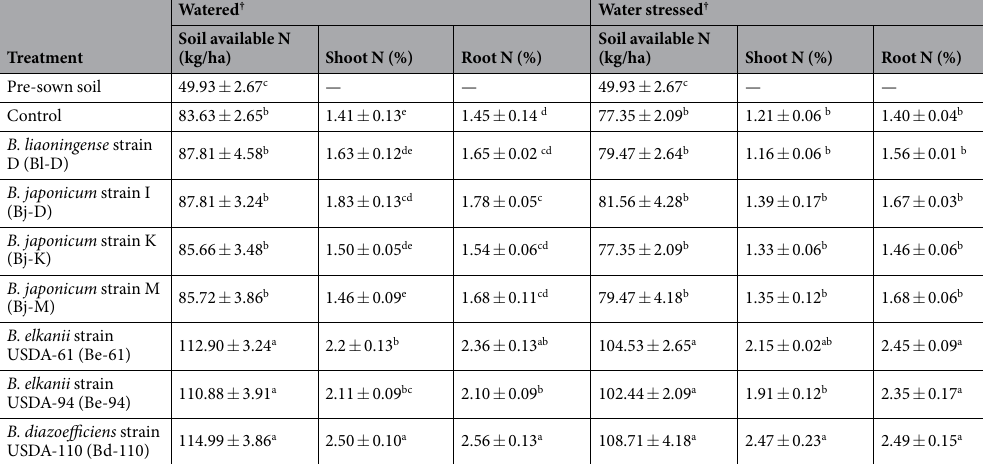
results therefore indicate comparable characteristics between these two groups of strains and suggest their simi- larities within clusters (Fig. 5 & Supplementary Table ST1). Correlation of parameters obtained from direct quantification and RGB based analysis. Table ST2). The correlation co-efficient (r-value) between the number of nodules vs blue pixels and number of nodules vs green pixels was estimated to be 0.677 and 0.775, respectively under watered conditions. The same was estimated to be 0.794 and 0.861 (which was supported by significant p-value) under water stressed conditions, indicating the plausibility of assessing the nodulation by examining plant surface phenotypes or canopy features like cool canopy and high canopy greenness (Table 4). Like nodulation efficiency, variables of RGB image based measurements have also been found to be directly correlated with the root, shoot nitrogen and total chlorophyll content in both watered and water stressed conditions. Also, the secondary factors were correlated more with green pixels than blue pixels and under water stressed conditions. Correlation analysis of watered and stressed